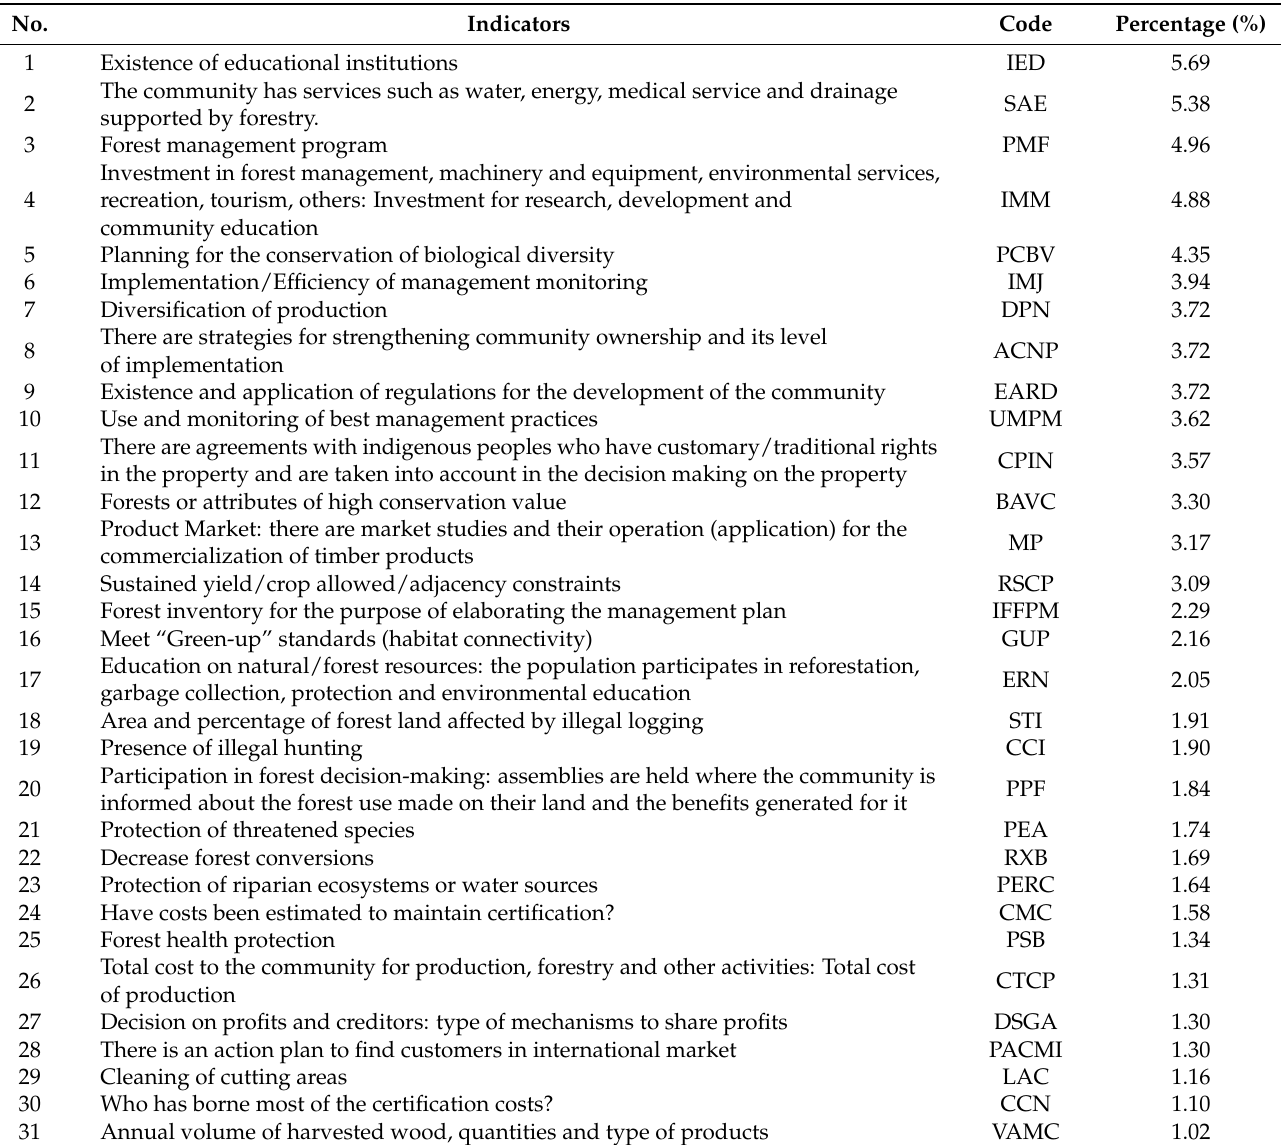
Table 4. Importance ranking in percentage of forest certification indicators assessed by the Analytical Hierarchy Process in this